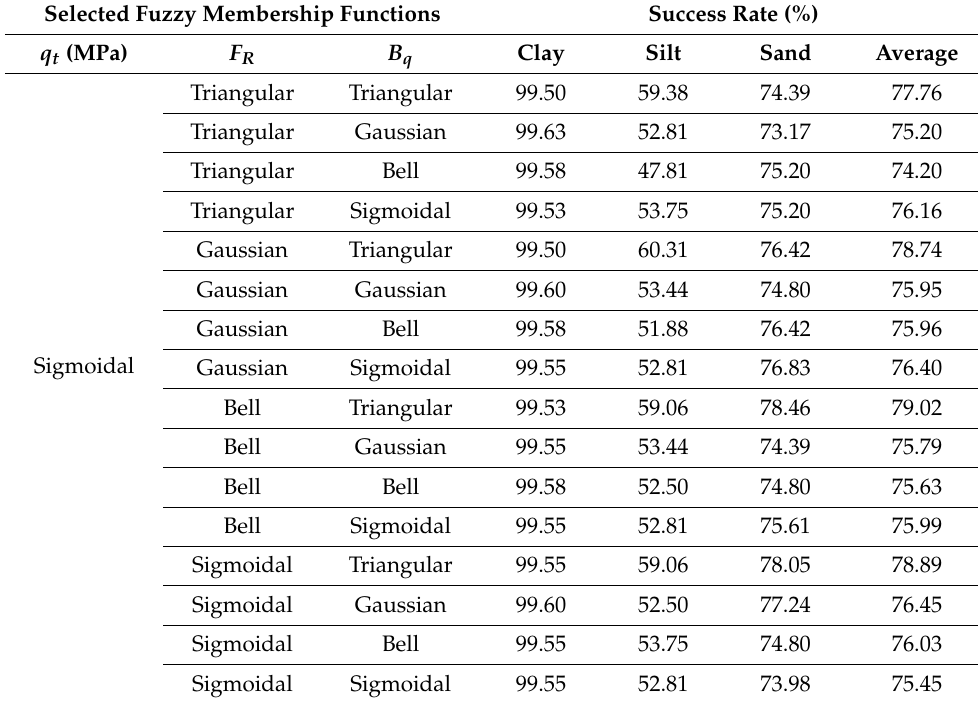
Table 7. Success rate when using a sigmoidal membership function for q t . Selected Fuzzy Membership